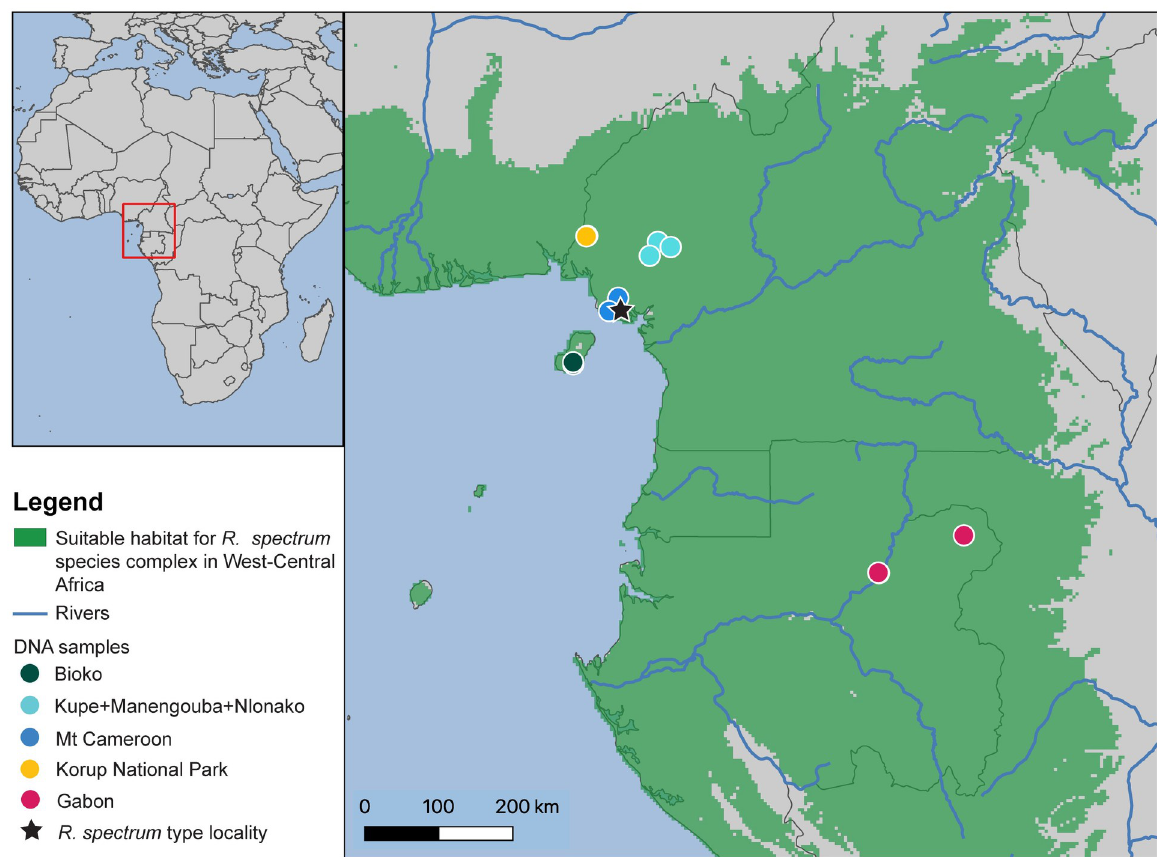
Fig 2. Map of suitable habitat for Rhampholeon spectrum species complex in West-Central Africa. Present-day suitable habitat was generated using kuenm. Sampling localities are indicated by various-shaded circles.